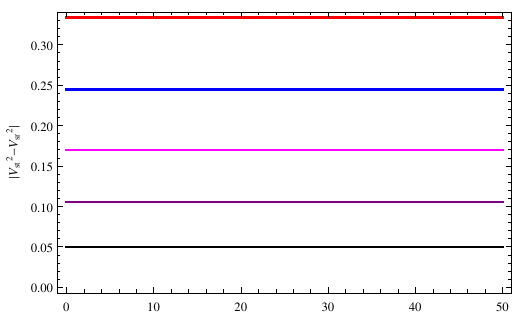
− v 2 | versus r for the strange star candidate LMC X − 4. The red, purple, magenta, Figure 8. Plot of | v 2 sr st blue and black colors represent respectively cases (cid:118) = 0, (cid:118) = 0.5, (cid:118) = 1, (cid:118) = 1.5 and (cid:118) = 2.